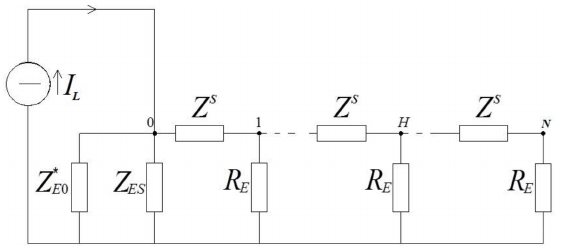
Figure 1. Equivalent ladder circuit model for the evaluation of the single-line-to-ground (1LtG) fault current distribution from an High Voltage/Medium Voltage (HV/MV) station to the supplied secondary